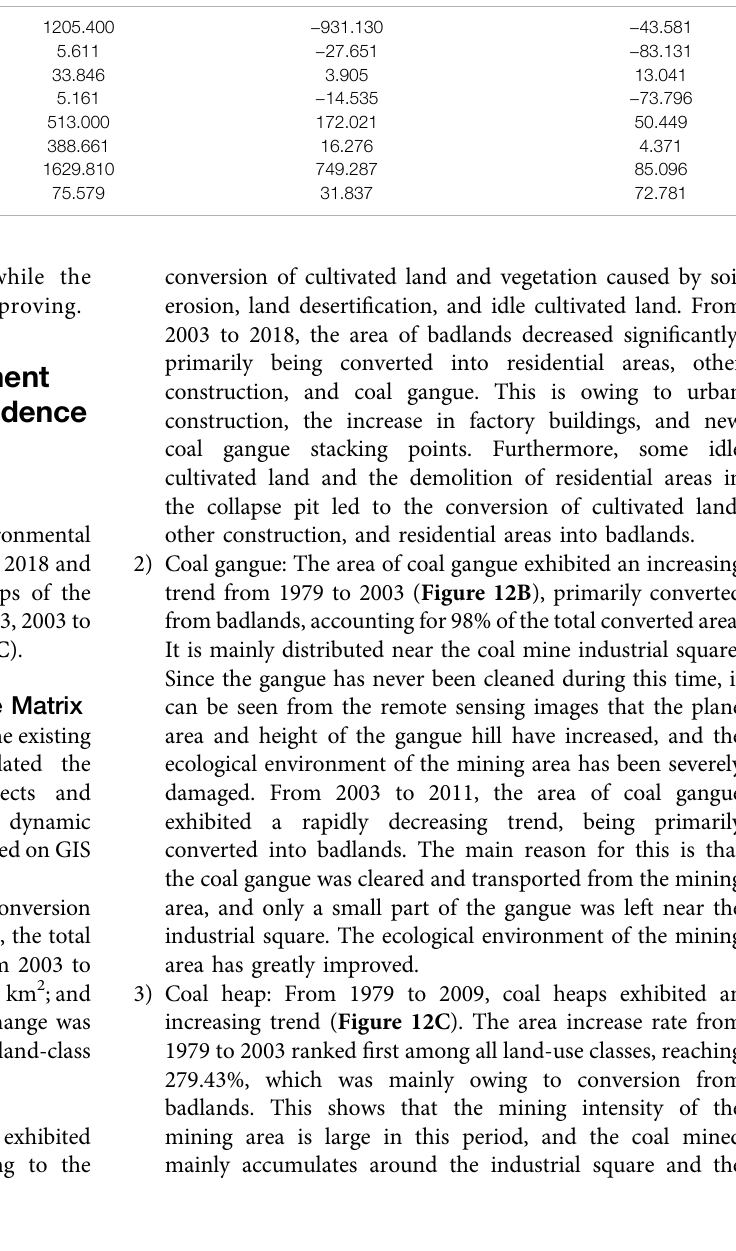
TABLE 7 | Land-use classes changes from 2011 to 2018 (unit: 10 – 2 km 2 ). Classes